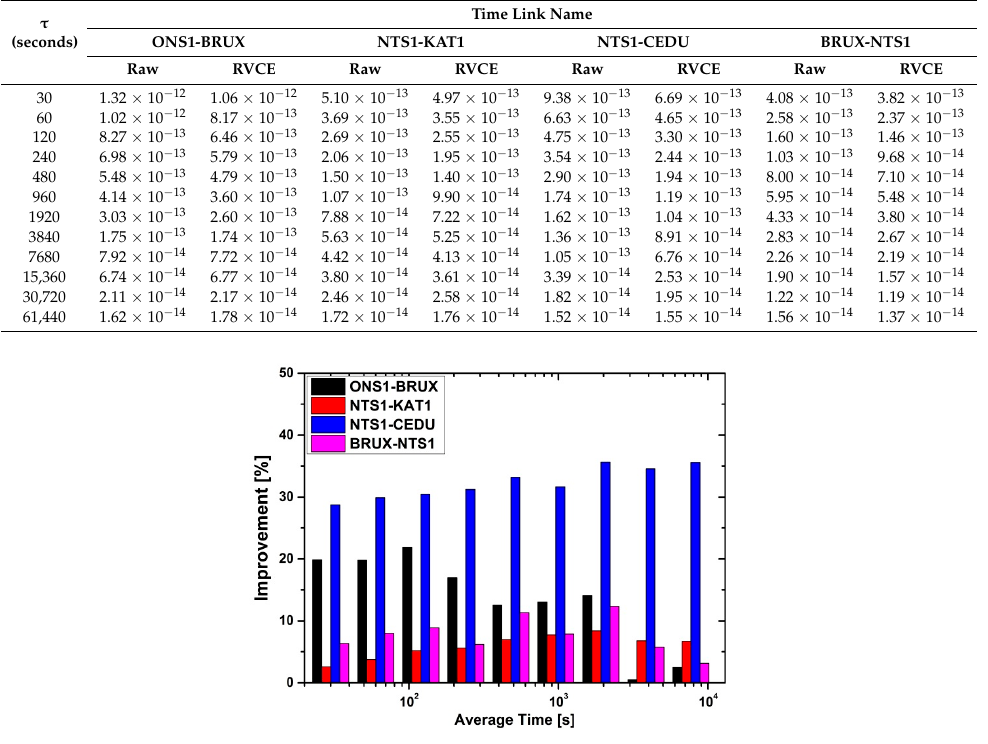
Figure 7. Improvement to stability (%) of RVCE solutions over the raw solutions within 10,000